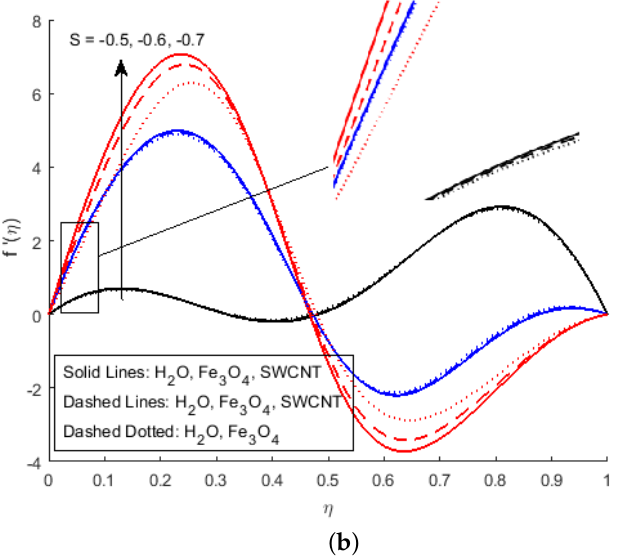
Figure 2. Effect of f ( η ) and f (cid:48) ( η ) for ( a ) S > 0, ( b ) S < 0 and fixed values of Re m = 1.5,